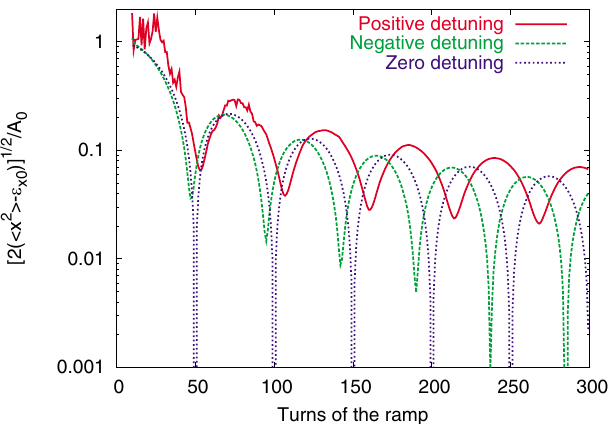
FIG. 4. (Color) Square root of twice the emittance blowup normalized to the amplitude of the driven oscillation with ; A versus the turns of the ramp for negative, frequency Q D 0 positive, and zero amplitude detuning.